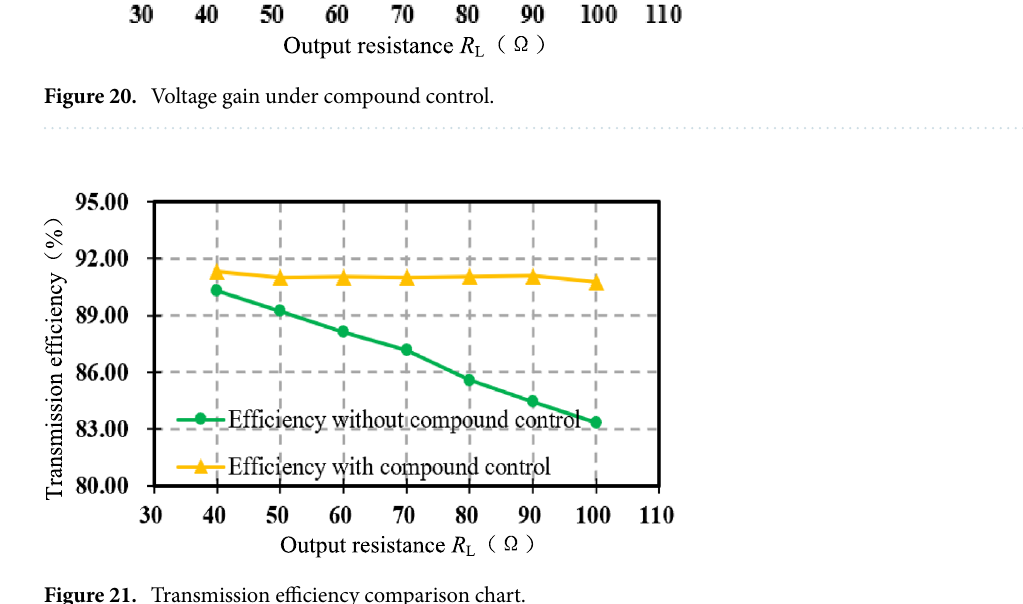
Figure 21. Transmission efficiency comparison chart.